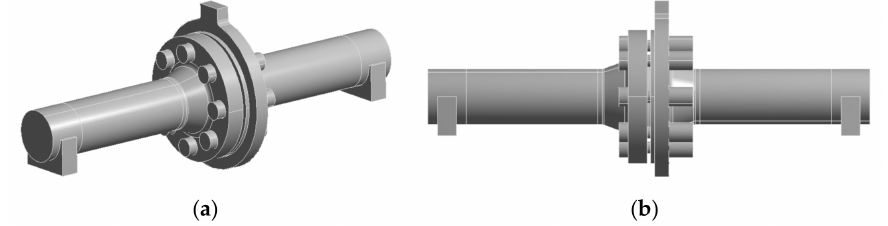
Figure 7. CAD model of the considered flanged-bolted joint of the pipeline fragment: ( a ) ISO view, ( b ) view from the side.